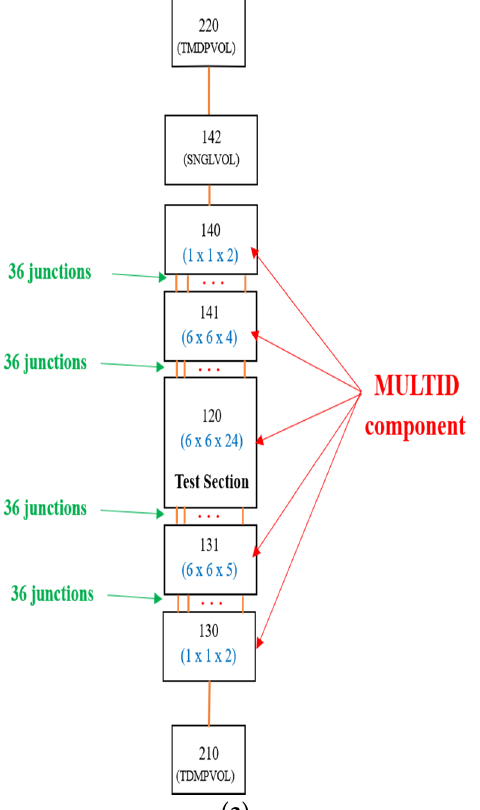
Figure 3. Cross-sectional view of nominal bundle test section.